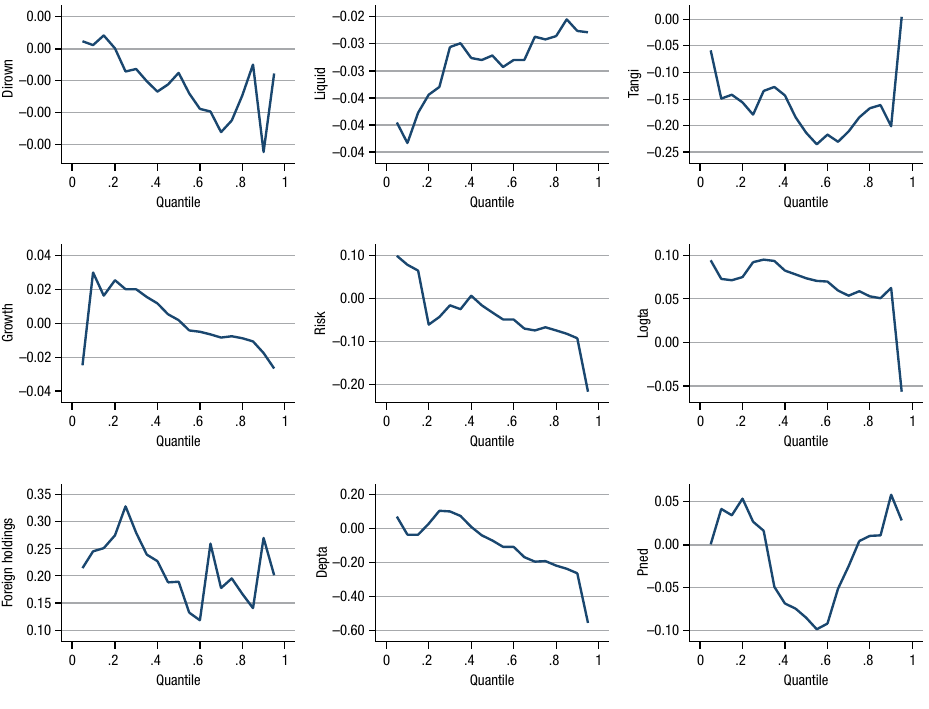
Fig. 1. Quantile regression